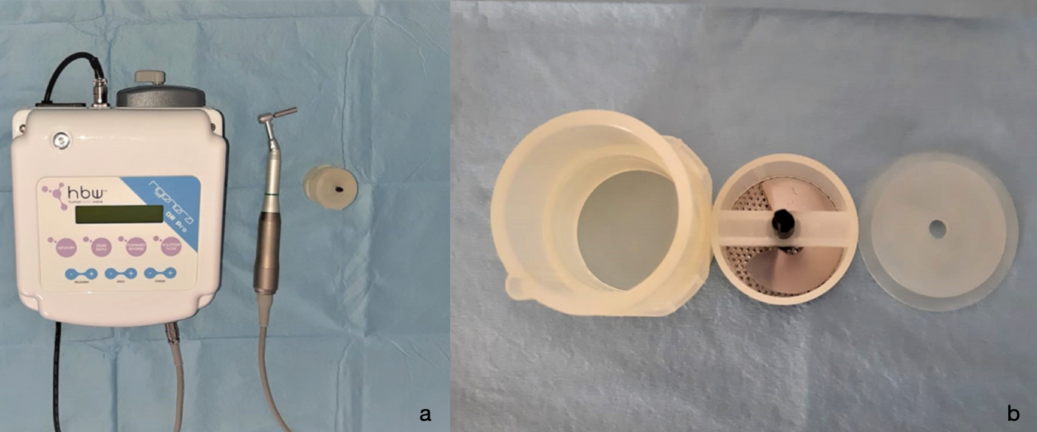
Figure 3. ( a ) Motorized apparatus of the Rigenera ® system; ( b ) RigeneraCons ® sterile capsule.